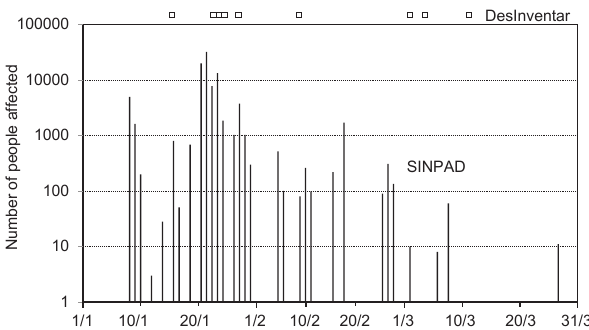
Figure 8. Comparison between individual disaster events for the January to March 2010 period as registered by DesInventar and SINPAD for the region of Cusco. The number of people affected ( y axis) only refers to SINPAD records; DesInventar just indicates the date of occurrence at the top of the